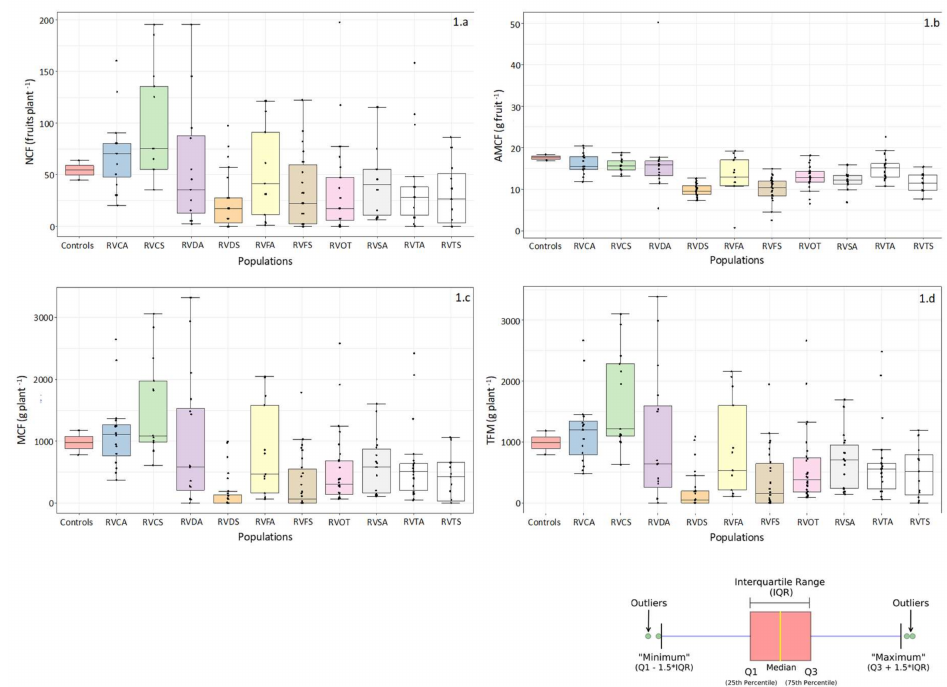
Figure 1. Analysis for ( a ) Number of Commercial Fruits (NCF, fruits / plant), ( b ) Average Mass of Commercial Fruits (AMCF, g / fruit), ( c ) Mass of Commercial Fruits (MCF, g / plant), and ( d ) Total Fruit Mass (TFM, g / plant) for genotypes of population evaluated.